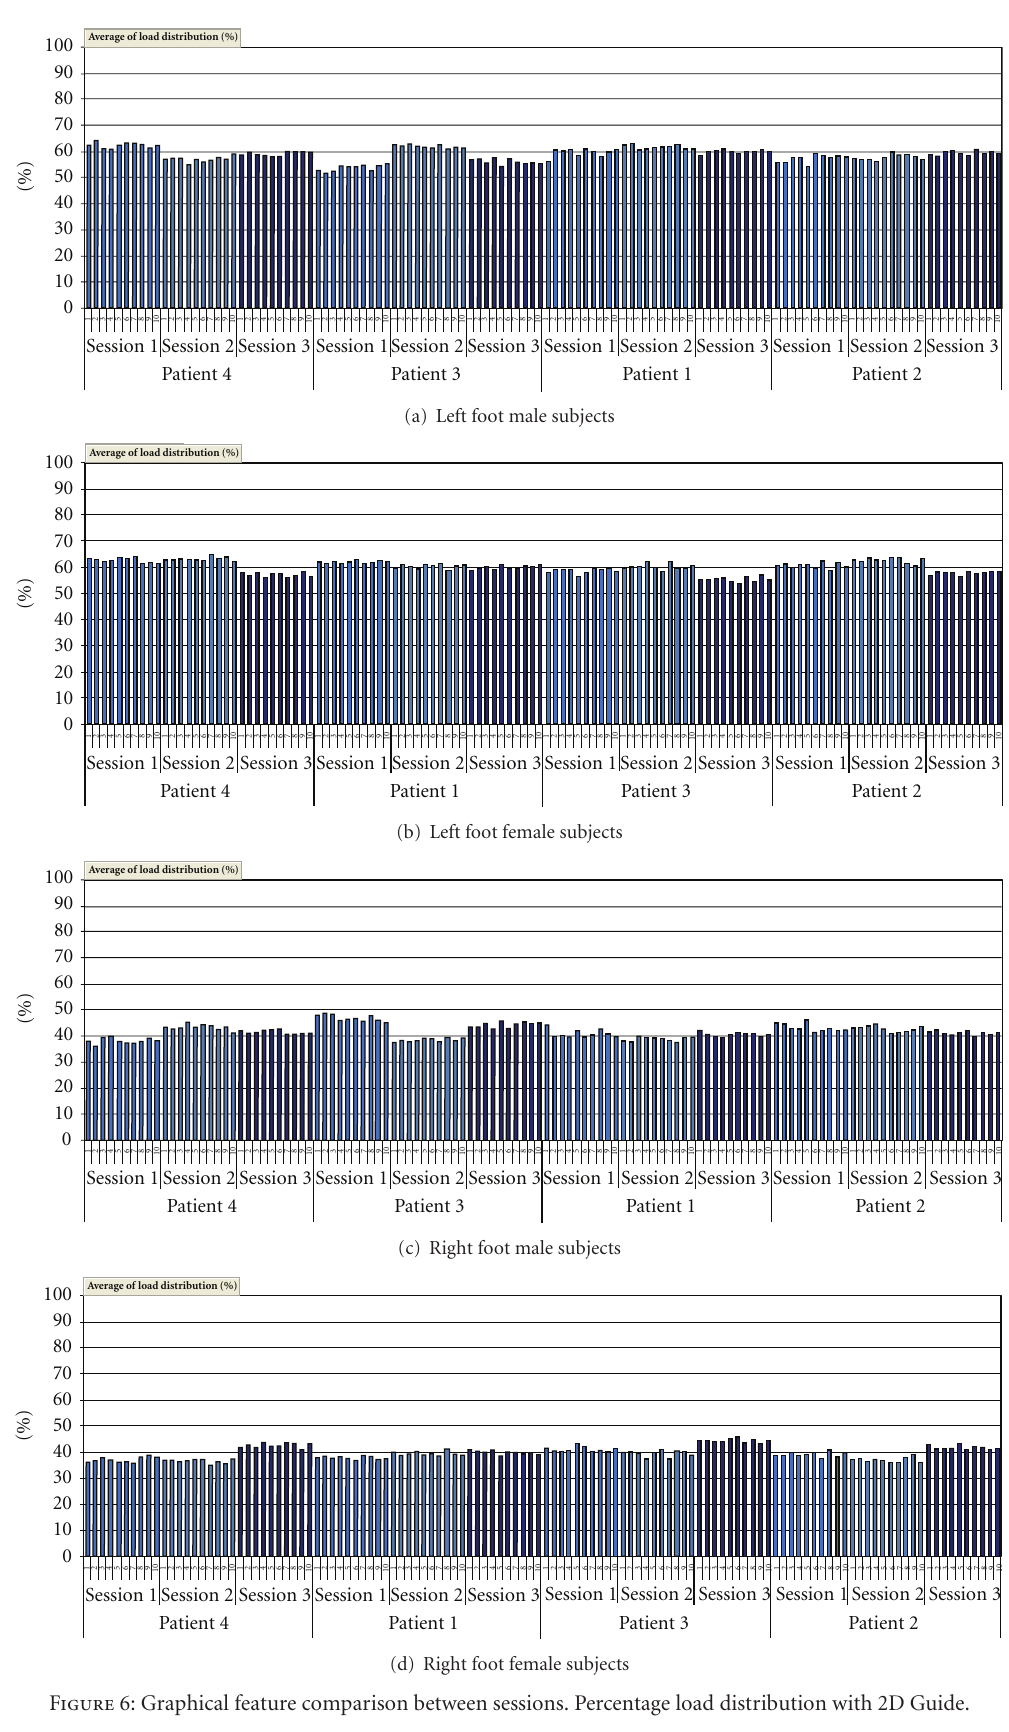
Figure 6: Graphical feature comparison between sessions. Percentage load distribution with 2D